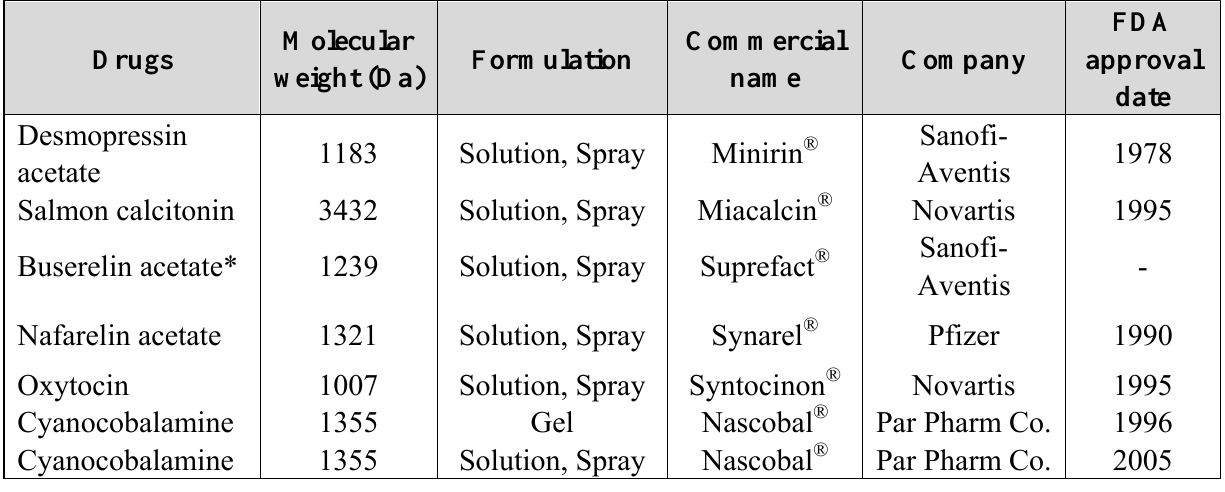
Table 1. Commercially available macromolecular drugs applied via nasal